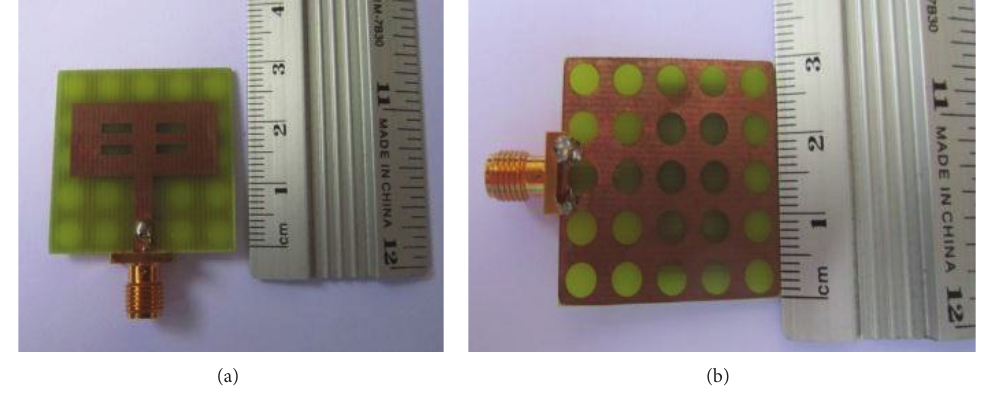
Figure 8: Prototyped DGS multiband resonator, (a) front side (b) back side.